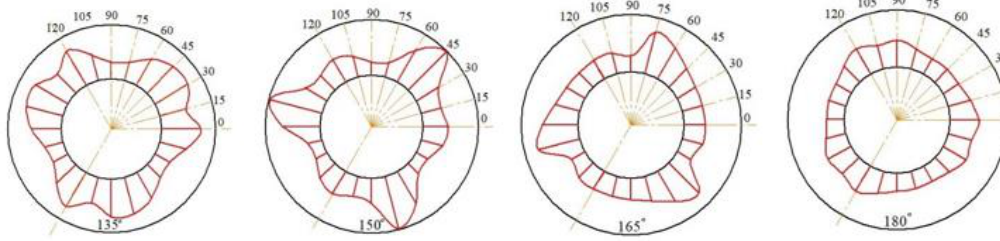
Figure 10a: Graphical representation of circumferential variation of stiffness for 3 grooves ISSFD